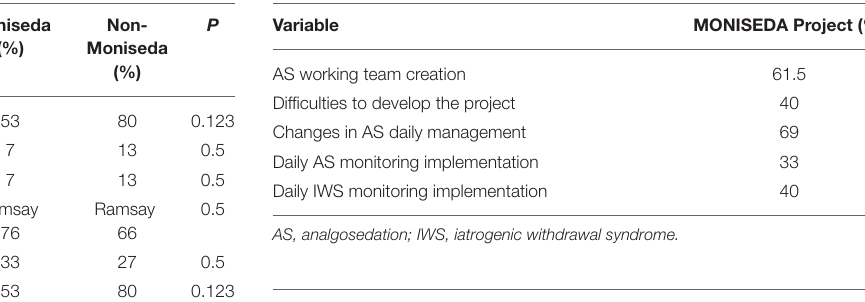
TABLE 4 | Final analgosedation survey (year